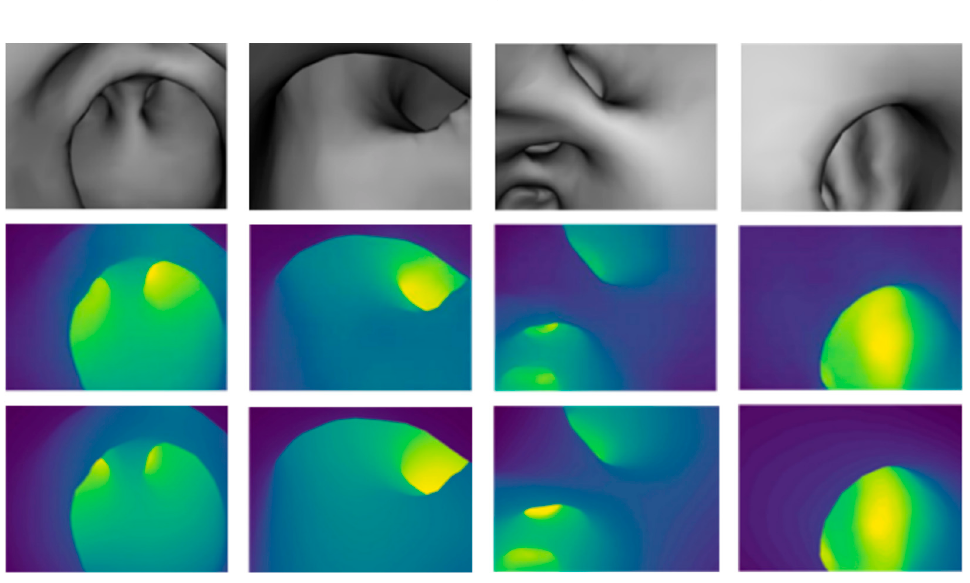
Figure 6. Examples of model depth map prediction results. The first row shows virtual endoscopic images (SI), the second row shows the predicted depth map, and the last row displays the ground truth of the depth map.